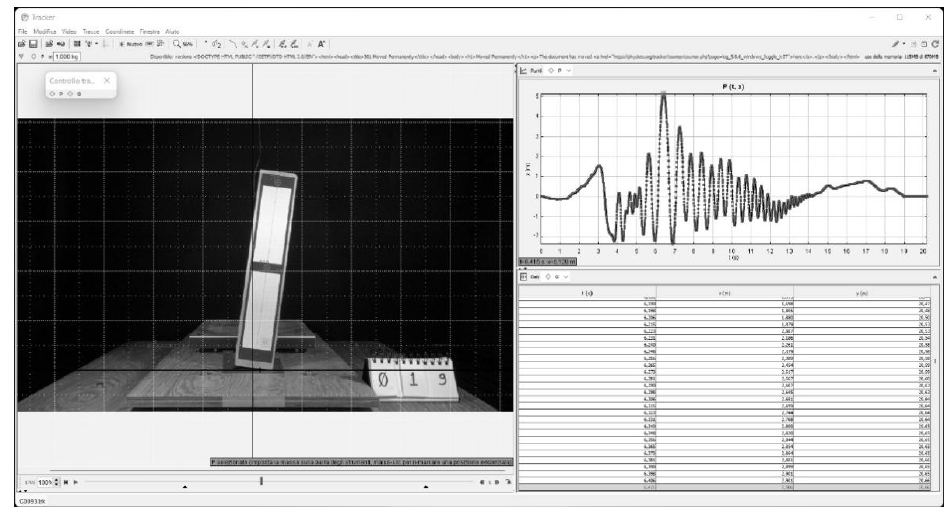
Figure 4. User interface Tracker software.